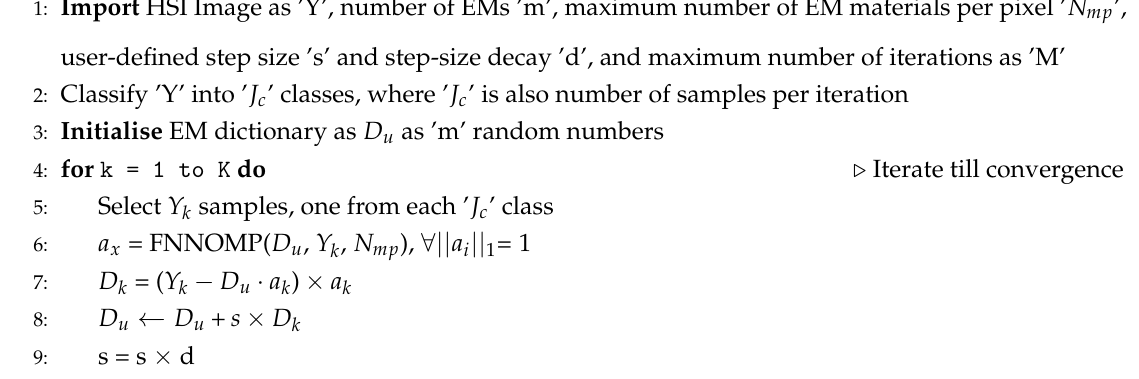
Algorithm 2 Proposed for scene simulators: